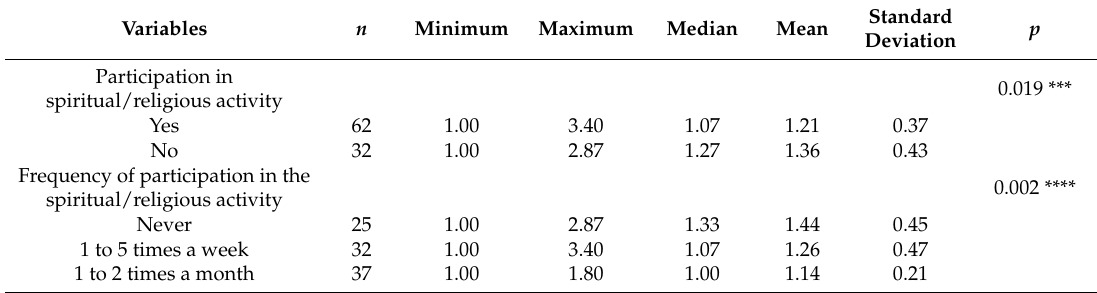
Table 4. Distribution of the participants of a rehabilitation center for mastectomized women, according to the comparison of the values of NSRC scores with the statistically significant variables. Ribeir ã o Preto, SP, Brazil, 2013–2014 ( n =